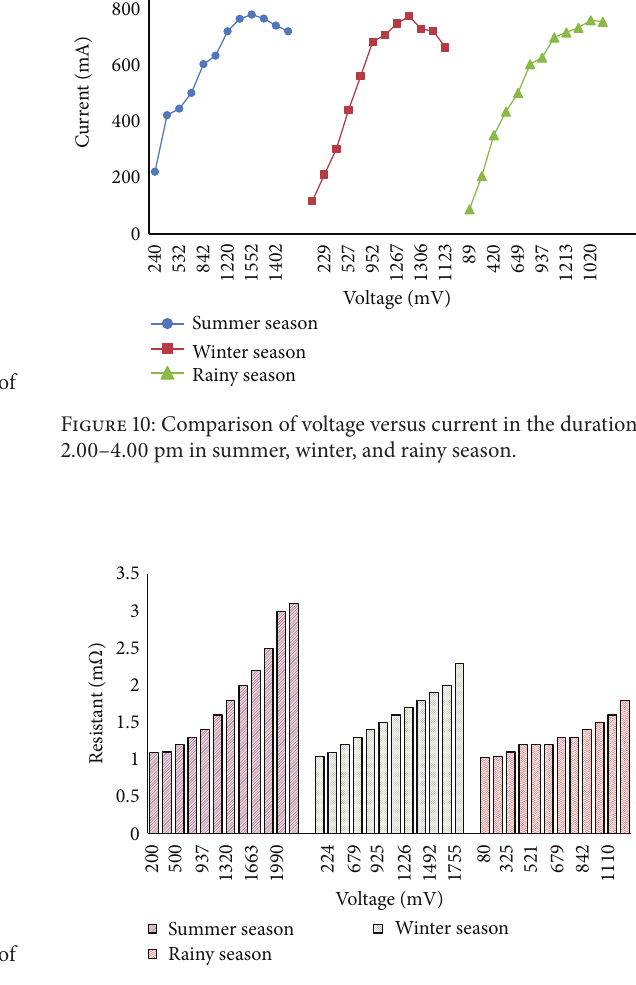
Figure 11: Comparison of voltage versus resistance in the duration of 8.00–10.00 am in summer, winter, and rainy season.